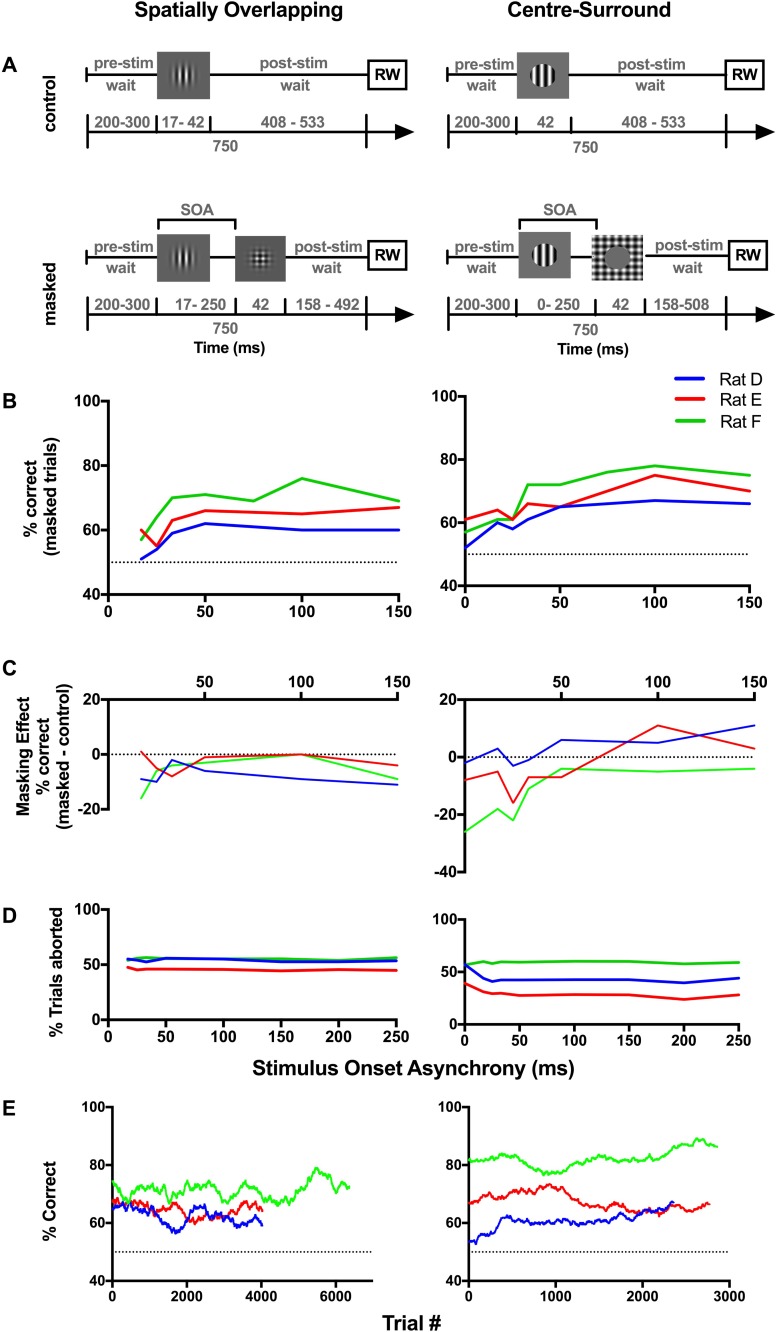
Spatially overlapping and centre-surround backward masking does not impair discrimination performance in rats.(A) Schematic of trial structure for control (top) and masked (bottom) trials using spatially overlapping (left) and centre-surround (right) stimuli. RW indicates the response window. (B) Orientation discrimination performance of three animals. The dotted line at 50% correct represents the chance performance level. (C) The effect of the mask, measured as the difference in performance between control and masked trials. The dotted line at 0% indicates when performance is equal across control and masked trials. (D) Percent aborted trials. (E) Overall task performance for each rat plotted as a 500-trial running average during data collection. Rats performed roughly 500 trials per day. For rat D, spatially overlapping data represents a summary of performance across an average of 378 trials/SOA and 63 sessions, centre-surround data 300 trials/SOA and 52 sessions (Rat E–SO: 370 trials/SOA; 77 sessions, CS: 320 trials/SOA; 52 sessions. Rat F–SO: 602 trials/SOA; 64 sessions, CS: 1083 trials/SOA; 112 sessions).